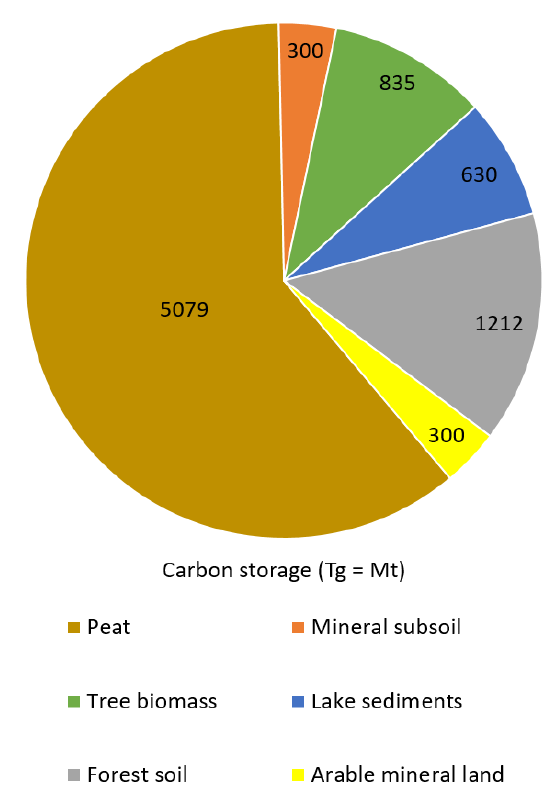
Figure 9. The peat carbon store for 2015 estimated in this study. Additionally, the distribution of other carbon stores of Finland are shown (Liski & Westman 1997, Turunen et al. 1999, Pajunen 2004, Kortelainen et al. 2004, Heikkinen 2016, Korhonen et al.